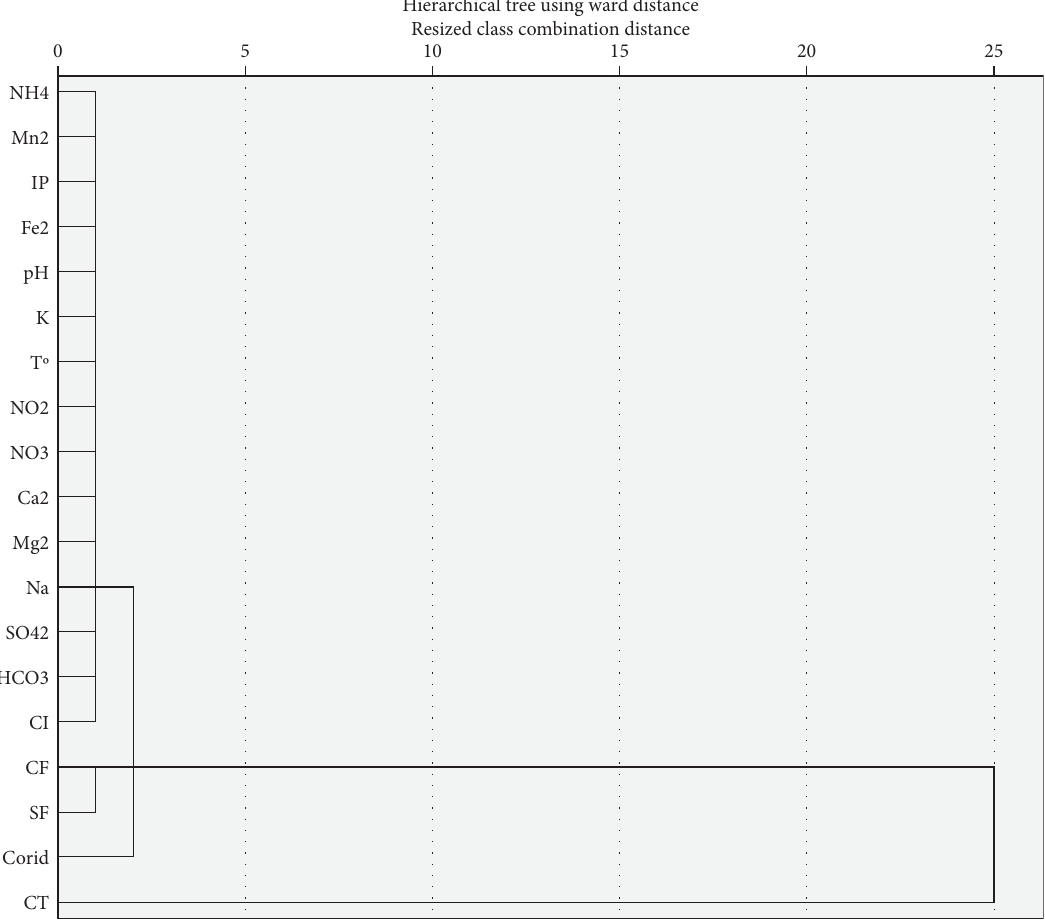
Figure 8: Dendrogram of nineteen physicochemical and bacteriological parameters of the Angads